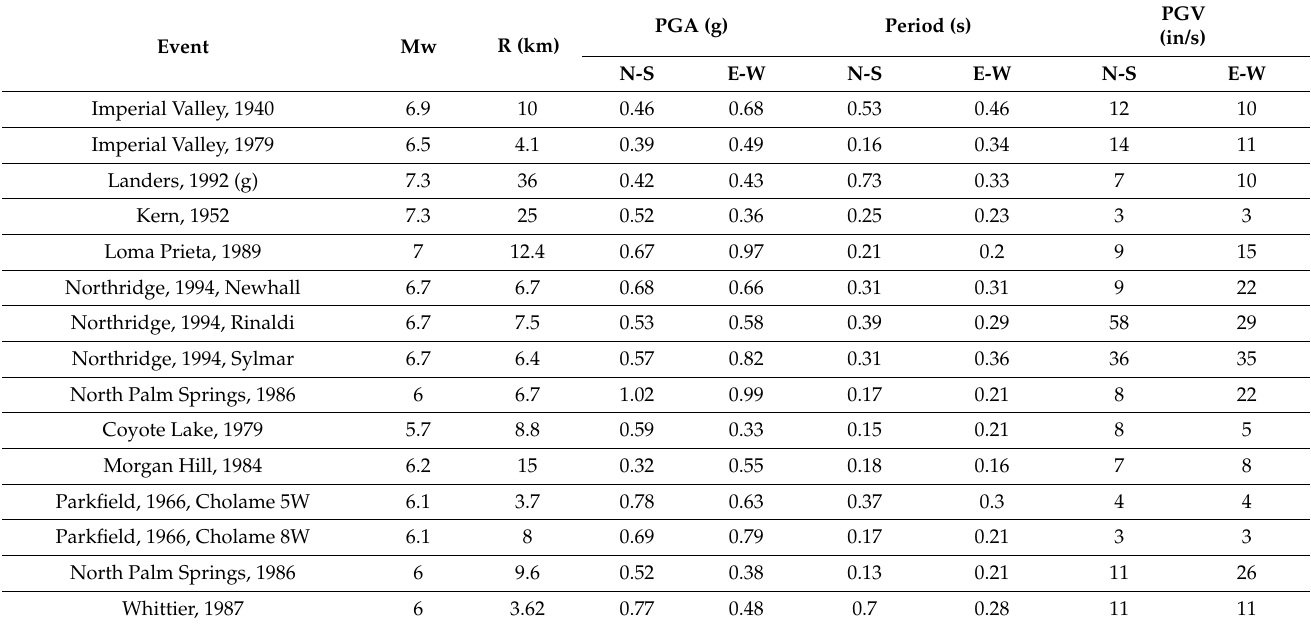
Table 3. Strong motion